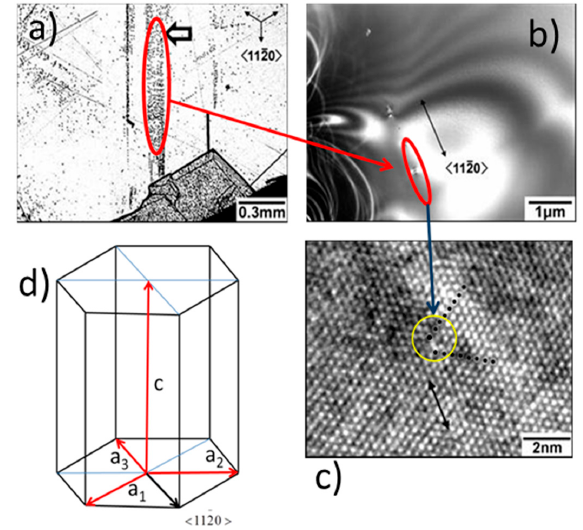
− − Figure 3. Dislocation gliding in the < 11 20 > { 1100 } slip system during post-growth cooling: ( a ) Optical −− >< slip system during post-growth Figure 3. Dislocation gliding in the }{ 10010211 micrograph; ( b ) electron microscope image of red circled region; ( c ) HRTEM pattern of crystal (dark cooling: ( a ) Optical micrograph; ( b ) electron microscope image of red circled region; ( c ) dots correspond to extra-atomic planes); ( d ) theoretical structure of the SiC crystal with a 1 = a 2 = a 3 HRTEM pattern of crystal (dark dots correspond to extra-atomic planes); ( d ) theoretical and dislocation’s Burgers vector oriented as a 3 . structure of the SiC crystal with a 1 = a 2 = a 3 and dislocation’s Burgers vector oriented as a 3.